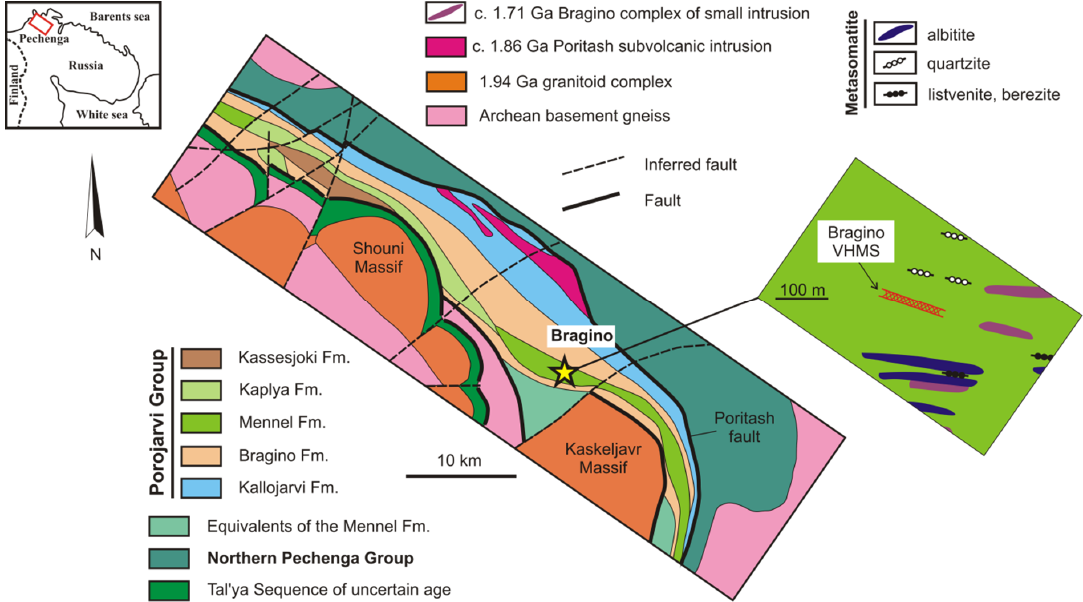
Figure 1. Geological map of the South Pechenga structural zone and position of the Bragino occurrence (modified after [22,24,26,28,32]).